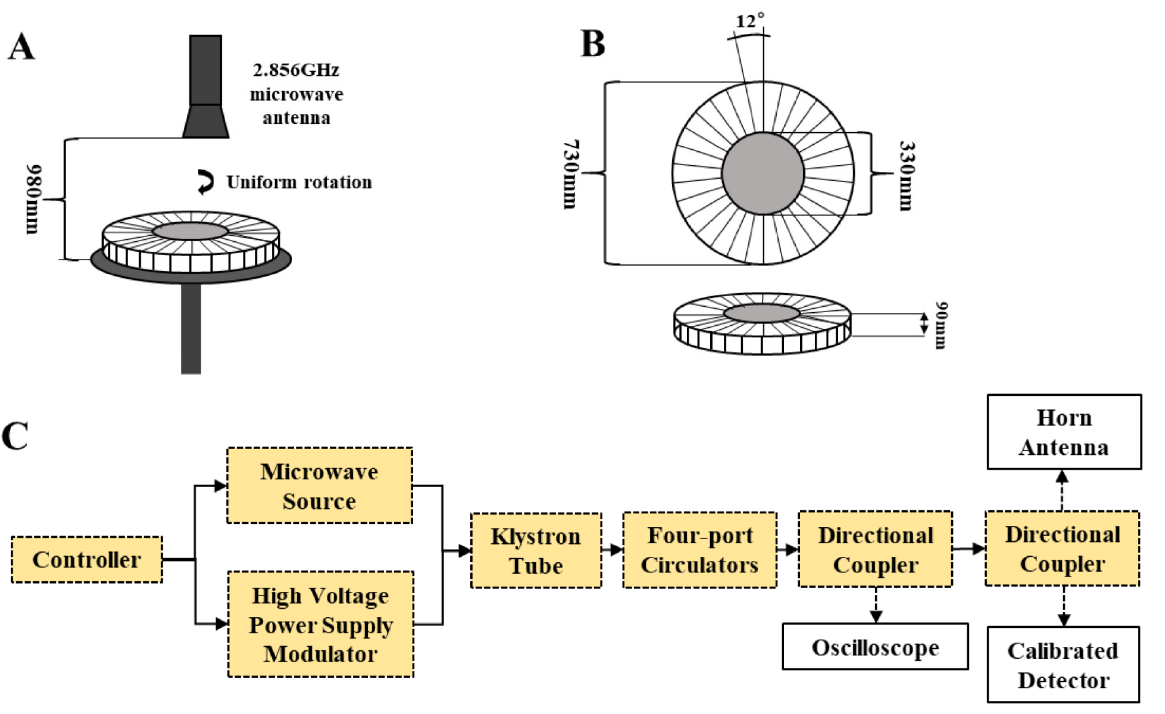
Figure 19. Diagram of the illumination device [15]. ( A ) Radiation table device; ( B ) radiation box; ( C ) microwave generator components and work fl ow (PD homogeneity of the disc area < 3 dB).